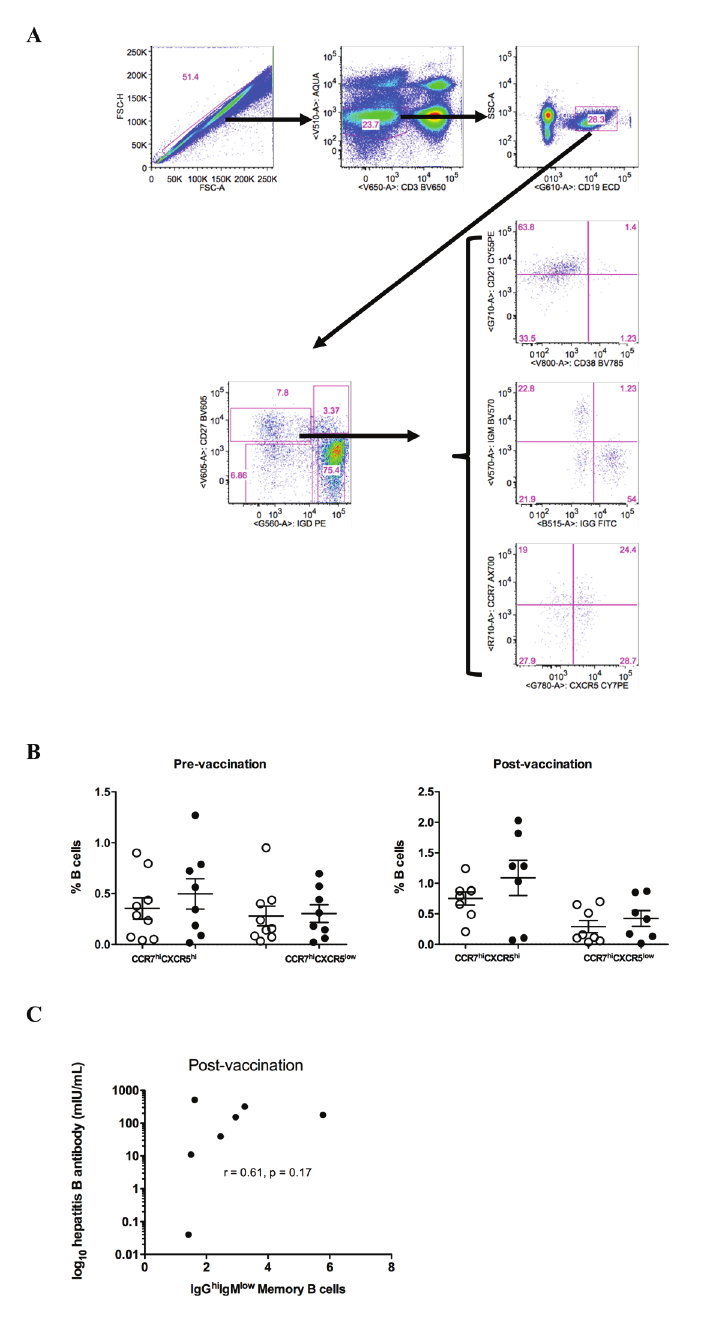
Supplementary Figure 2. (A) Gating scheme for phenotypic analysis of B cell subsets, (B) Pooled data showing the relative frequency of circulating memory B cells with respect to expression of CCR7 and CXCR5 chemokine receptors and (C) Scatterplot of HBV antibody concentration and the frequency of IgG high IgM low switched memory B cells (only 7 HBV responding donors had a measurable response). P -val- ues calculated with Mann-Whitney test and (B) and Spearman correlation test